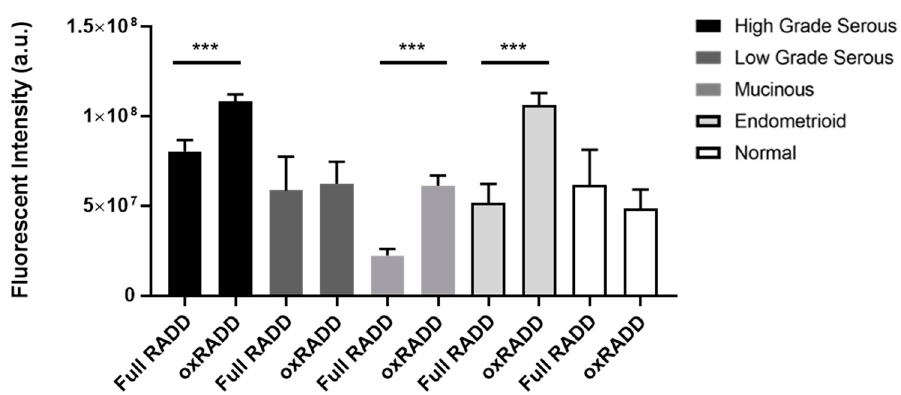
Figure 3. Comparing the Full RADD cocktail to an oxidative DNA damage-specific cocktail (oxRADD) across the pathological subtypes. The mean fluorescent intensity with the standard error of the mean (SEM) is shown in the bar graph for full RADD and oxRADD for each subtype. *** p < 0.001.